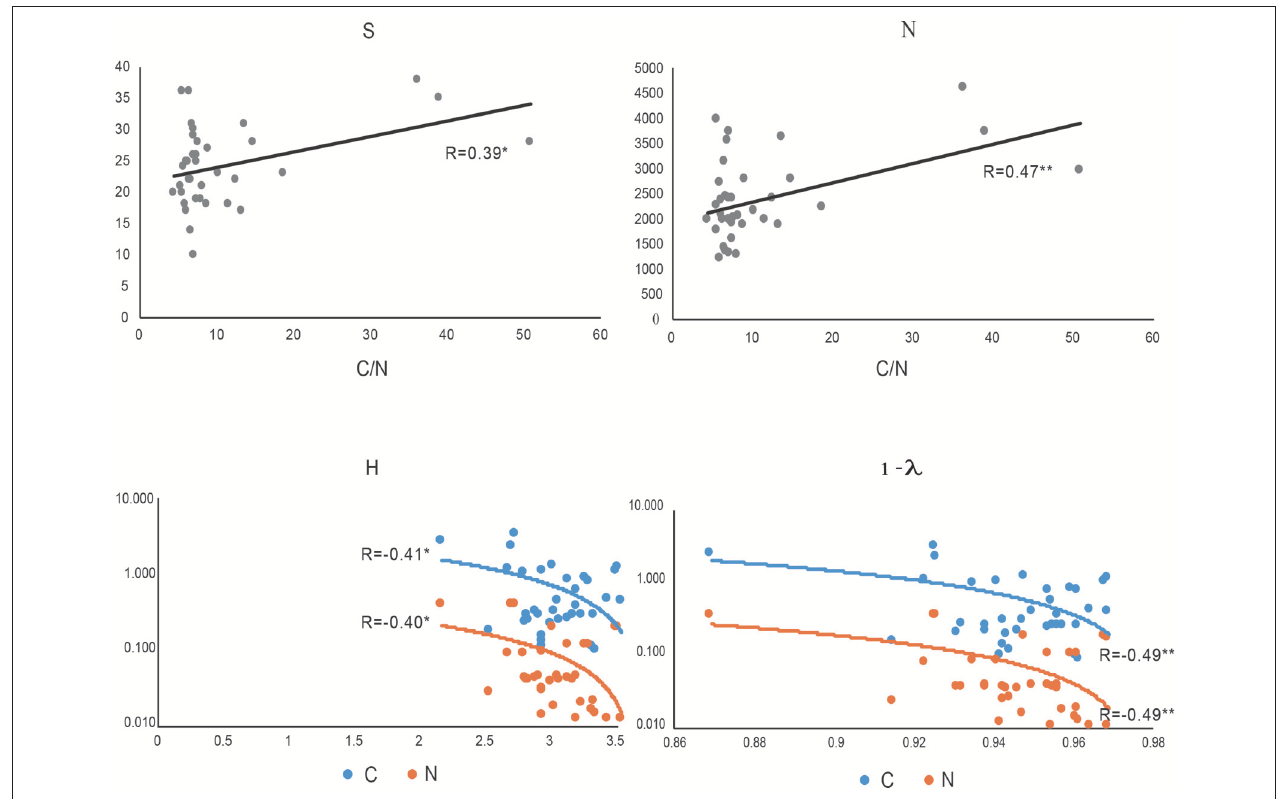
FIGURE 6 | The most important correlation between biodiversity index: S (species number), N (individual number, Shannon-Wiener (H) and Simpson (represented by 1- λ ) and C/N ratio (gray), C (blue) and N